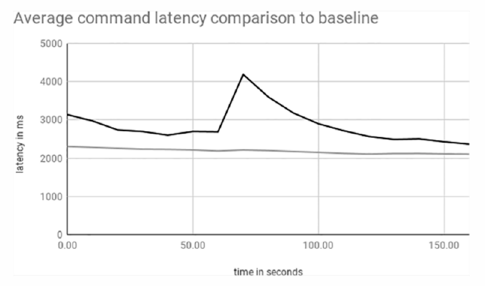
Figure 20. Average write latency of scaled cluster versus the baseline, single shard cluster.